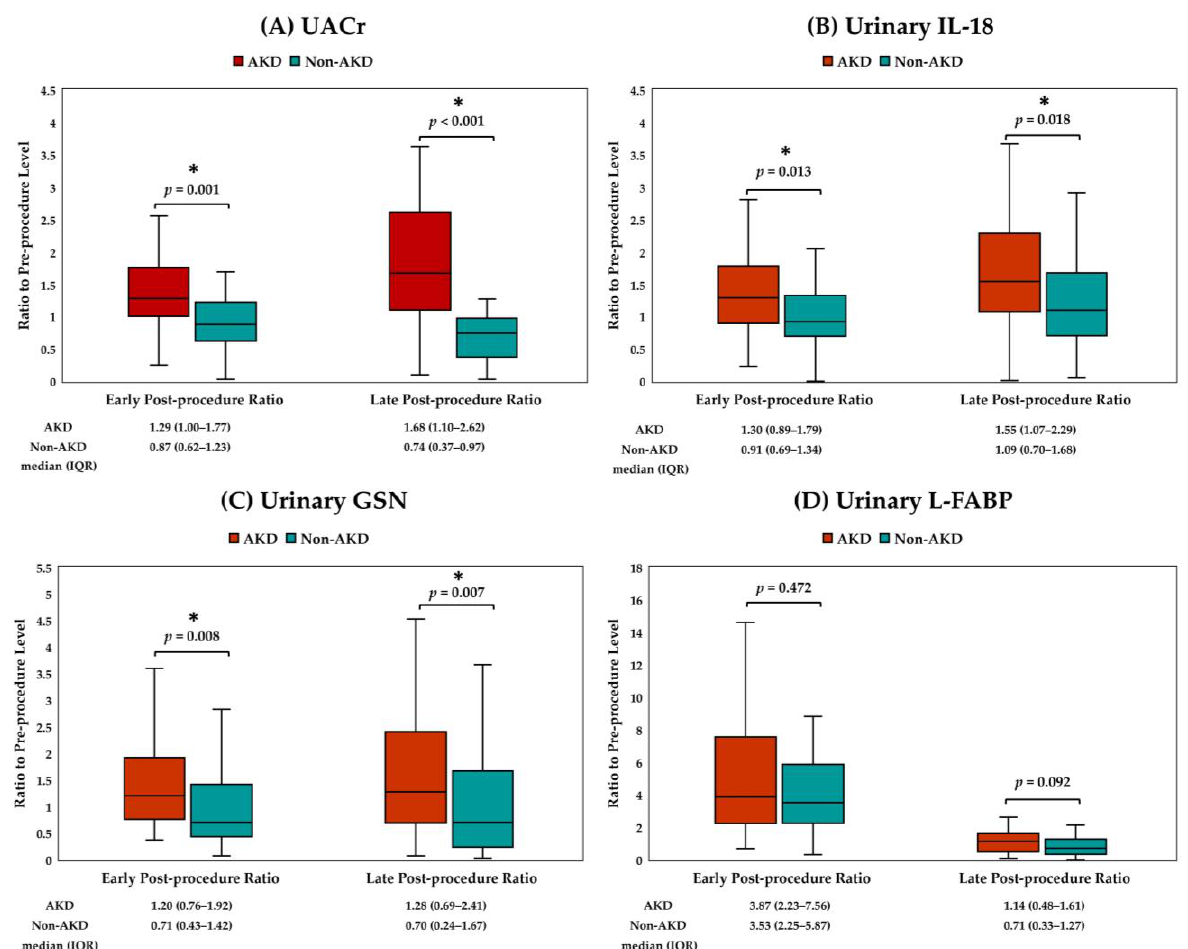
Figure 3. Comparisons of Post-procedure Ratios of Urinary Biomarkers between Groups. ( A ) UACr; ( B ) urinary IL-18; ( C ) urinary GSN; ( D ) urinary L-FABP. The post-procedure ratio of a urinary bi-